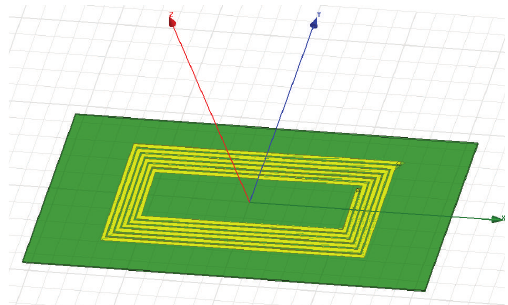
Figure 2: Typical PICC antenna geometry: 70 × 30 mm size, 𝑁 = 6 turns, conductor width 𝑤 = 1 mm, and pitch 𝑝 = 2 mm. Card substrate is Rogers RO4350 and the thickness is 51mm.